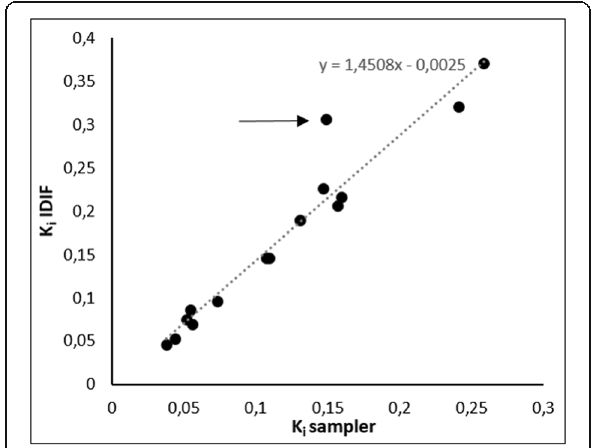
Fig 3 Correlation between [ 18 F]afatinib K i values obtained using on- line sampler and IDIF input functions